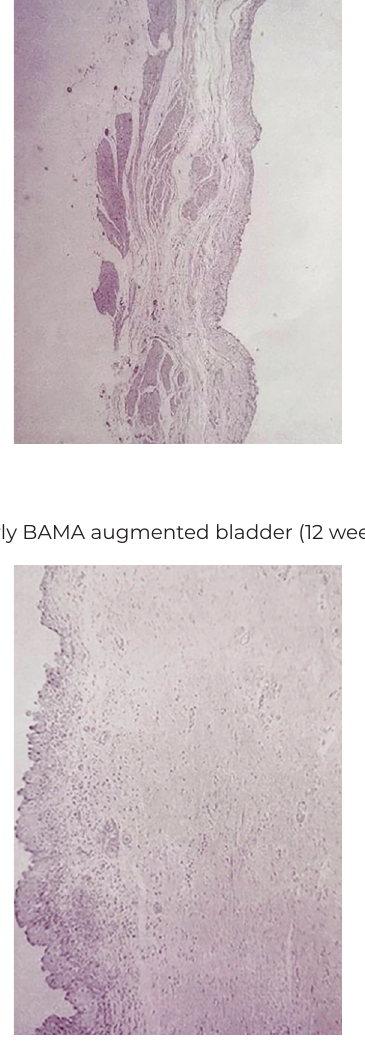
Figure 2 - Only parcial cystectomized bladder